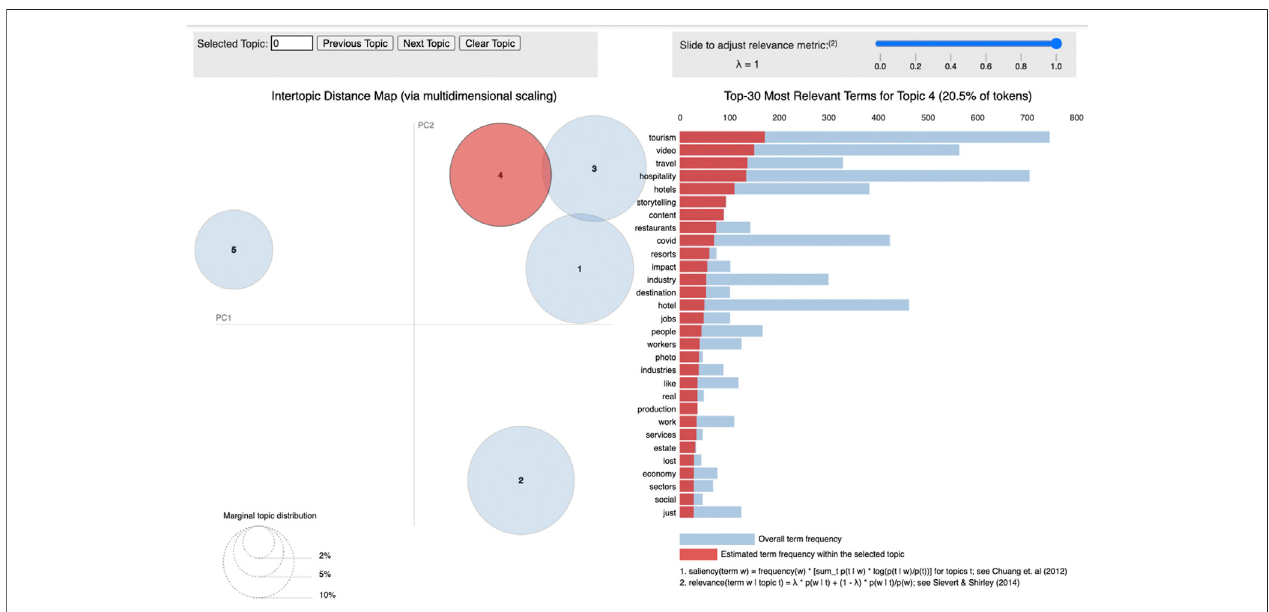
FIGURE 3 | Interactive topic modeling visualization for tourism hospitality